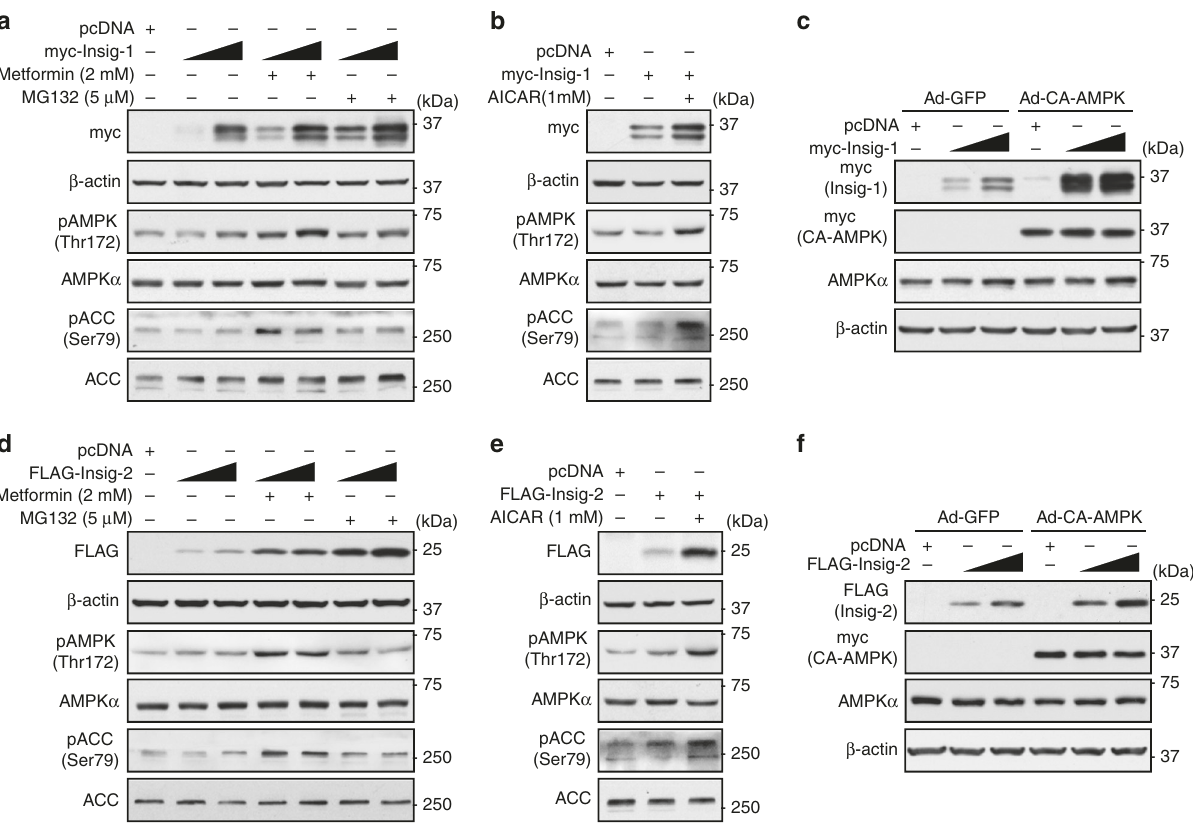
Fig. 2 Activation of AMPK enhances the protein levels of both Insig-1 and Insig-2. a – c AMPK agonists increase the protein levels of Insig-1. HEK293 cells were transfected with pcDNA or myc-tagged Insig-1 for 24 h, followed by treatment with 2 mM metformin or 5 μ M MG132 ( a ), or 1 mM AICAR ( b ) as indicated; and HepG2 cells were transfected with pcDNA or myc-tagged Insig-1 for 24 h, and then infected with adenoviruses encoding constitutive active AMPK (CA-AMPK) or GFP for 48 h ( c ). Immunoblots were performed. d – f AMPK agonists increase the protein levels of Insig-2. HEK293 cells were transfected with pcDNA or FLAG-tagged Insig-2 for 24 h, followed by treatment with 2 mM metformin or 5 μ M MG132 ( d ), 1 mM AICAR ( e ); and HepG2 cells were transfected with pcDNA or FLAG-tagged Insig-2 for 24 h, and then infected with adenoviruses encoding CA-AMPK or GFP for 48 h ( f ). Immunoblots were